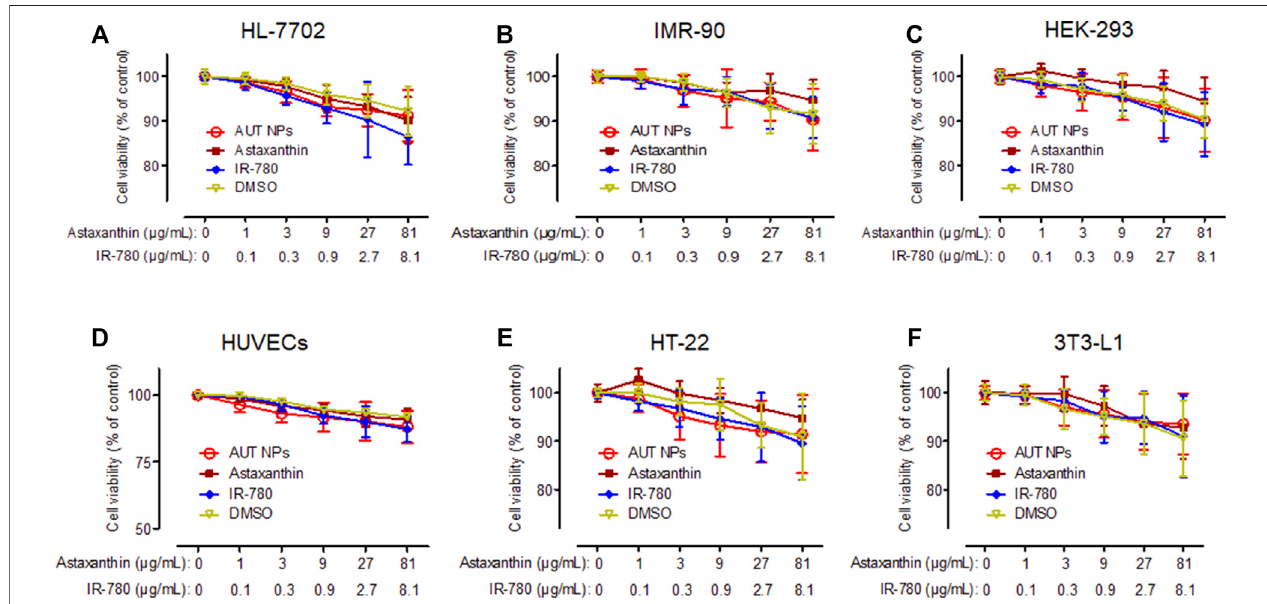
FIGURE 3 | The in vitro cytotoxicity results of AUT NPs, ATX, IR780, and DMSO in HL-7702 (A) , IMR-90 (B) , HEK-293 (C) , HUVECs (D) , HT-22 (E) , and 3T3-L1 (F) cells.